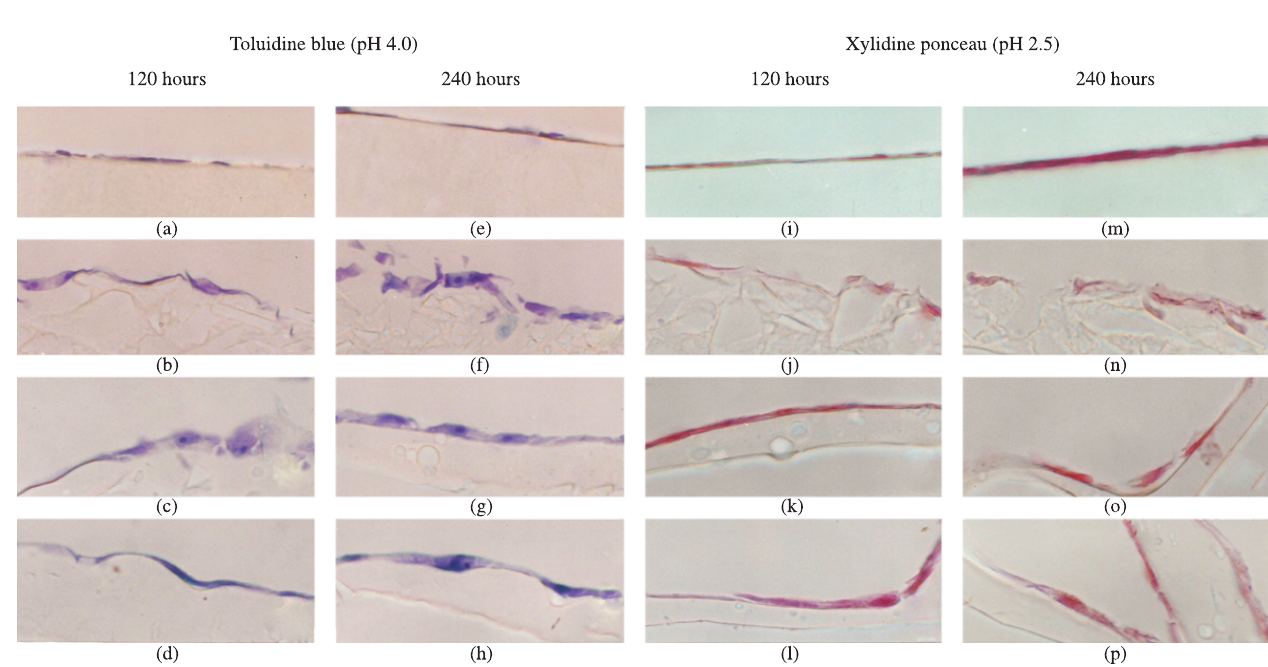
Figure 3. Growth curve of Vero cells cultured on dense or porous PLLA membranes.